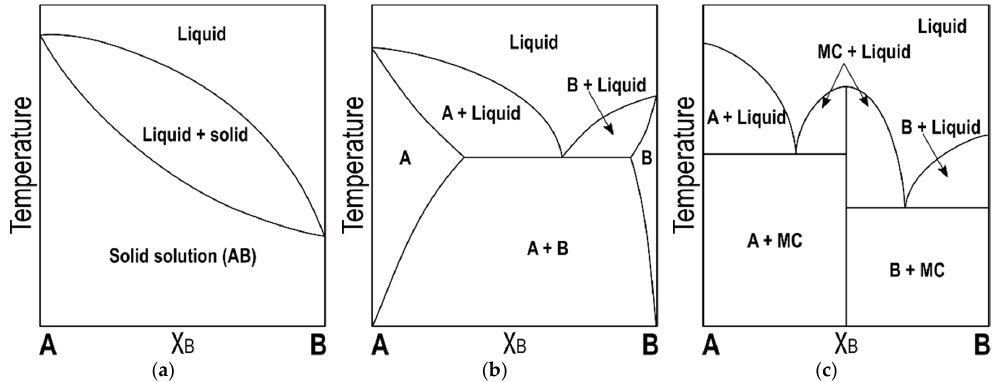
Figure 1. Typical phase diagrams exhibited by binary mixtures of triacylglycerols (TAGs). ( a ) Solid solution; ( b ) eutectic behavior; and, ( c ) molecular compound (MC) formation.